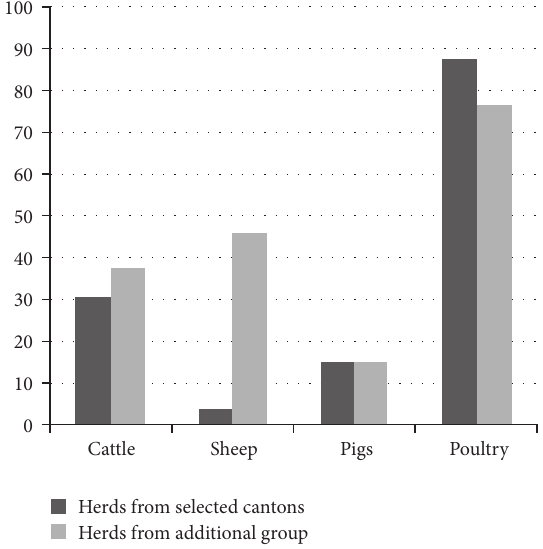
Figure 1: Herds stating mixed farming systems: divided by species and presented in